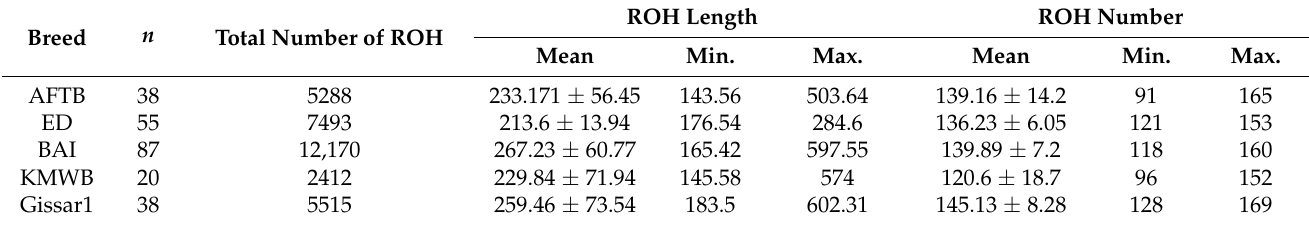
Table 4. Descriptive statistics for runs of homozygosity for five sheep